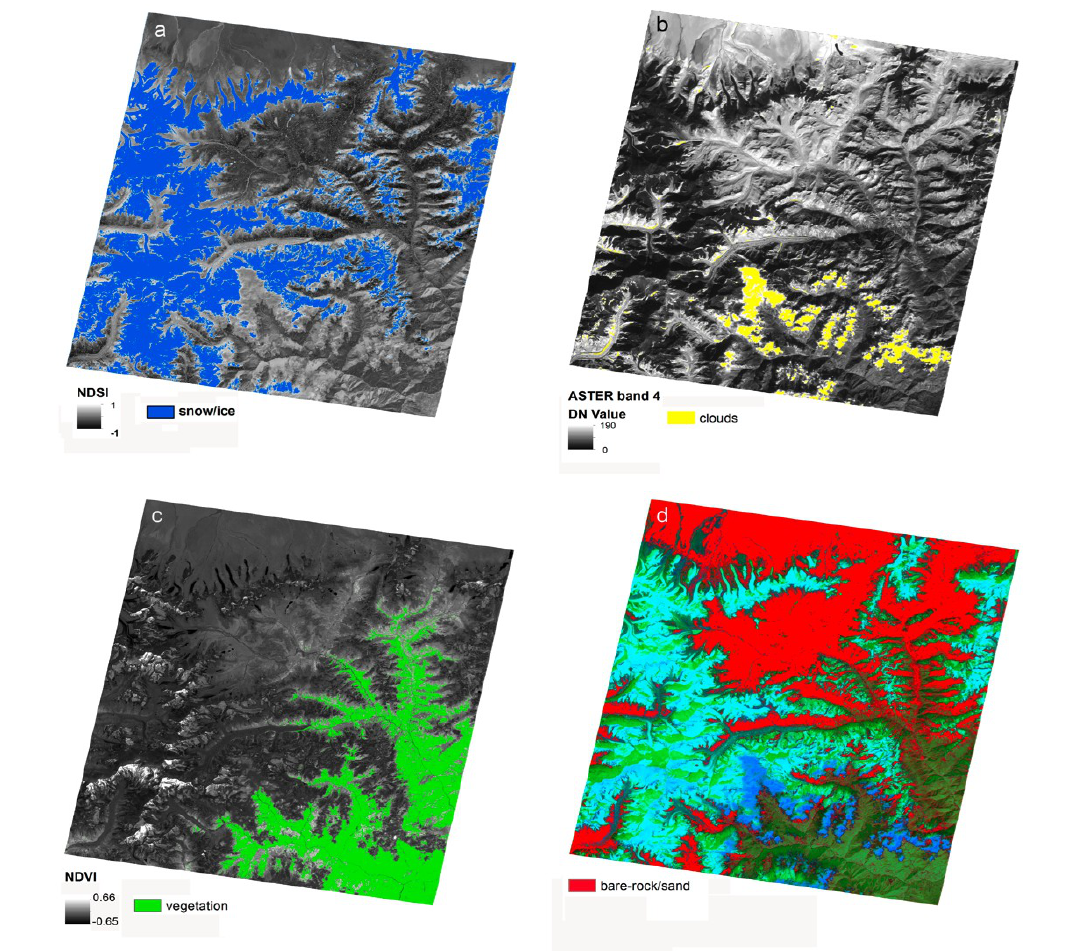
Figure 8. Four of the classes resulting from the multispectral criteria, shown as examples of the output of the criteria in the decision tree in Figure 7: ( a ) NDSI map with clean glacier areas in blue; ( b ) ASTER band 4 with cloud outlines in yellow; ( c ) NDVI map with vegetation mask in green and ( d ) HSV 235 color transform with the hue component for non-vegetated bare rock/sand shown in